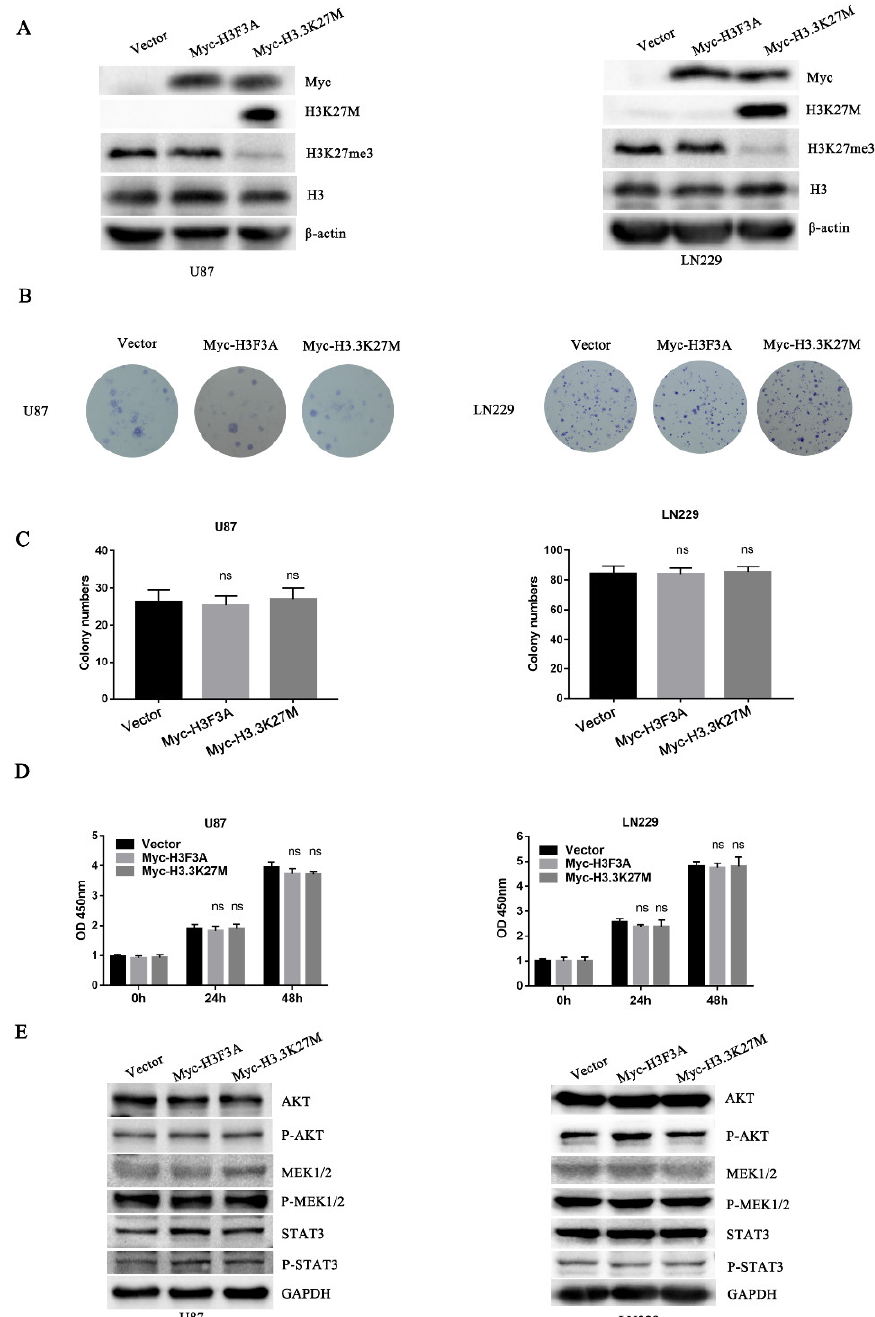
Figure 2. Colony formation and CCK-8 assays showed that H3.3K27M had no obvious effect on proliferation of glioma cells in vitro , and Western blotting showed that H3.3K27M did not change the levels of kinases involved classical proliferation pathways. ( A ) The overexpression efficiency in U87 and LN229 cells was verified using Western blotting. H3K27M was accompanied by a loss of H3K27me3, and no difference in the total amount of H3 was observed among the three groups. Representative images ( B ) and statistical analysis ( C ) of colony formation showed no discernible difference among the vector group, Myc-H3F3A group and Myc-H3.3K27M group in U87 and LN229 cells. ( D ) The CCK-8 assay revealed no significant effect on the proliferation of the three groups of U87 and LN229 cells. ( E ) Representative blots of AKT, P-AKT, MEK1/2, P-MEK1/2, STAT3 and P-STAT3 levels in the three groups of U87 and LN229 cells. ns indicates no statistical significance.